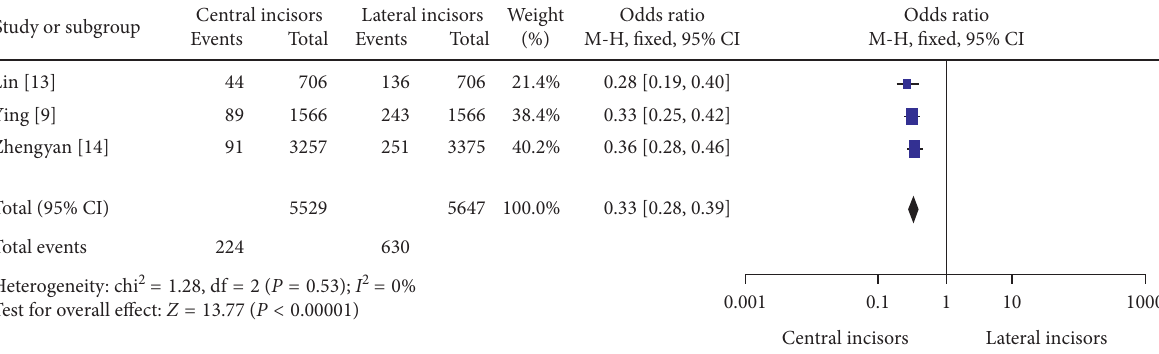
Figure 2: The evidence of Vertucci’s Type ΙΙΙ canal configurations between permanent mandibular central and lateral incisors in